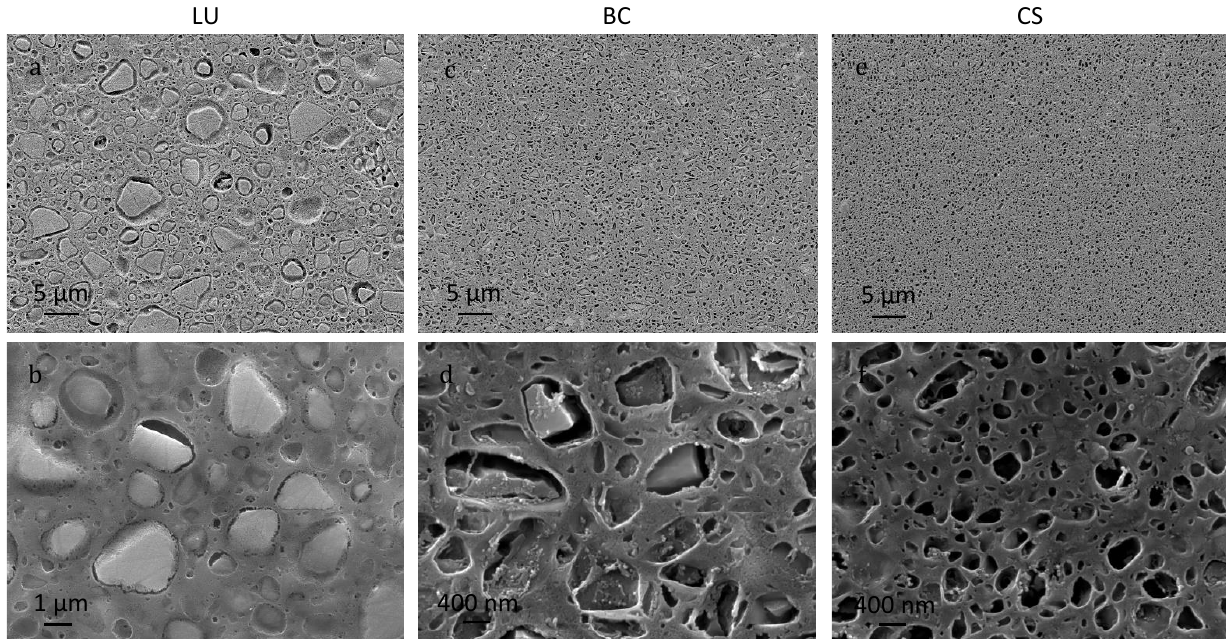
Figure 5. FESEM micrographs of polished and etched surfaces of ( a,b ) LU, ( c,d ) BC, and ( e,f ) CS materials. Note that micrography of LU has a lower magnification than BC and CS.